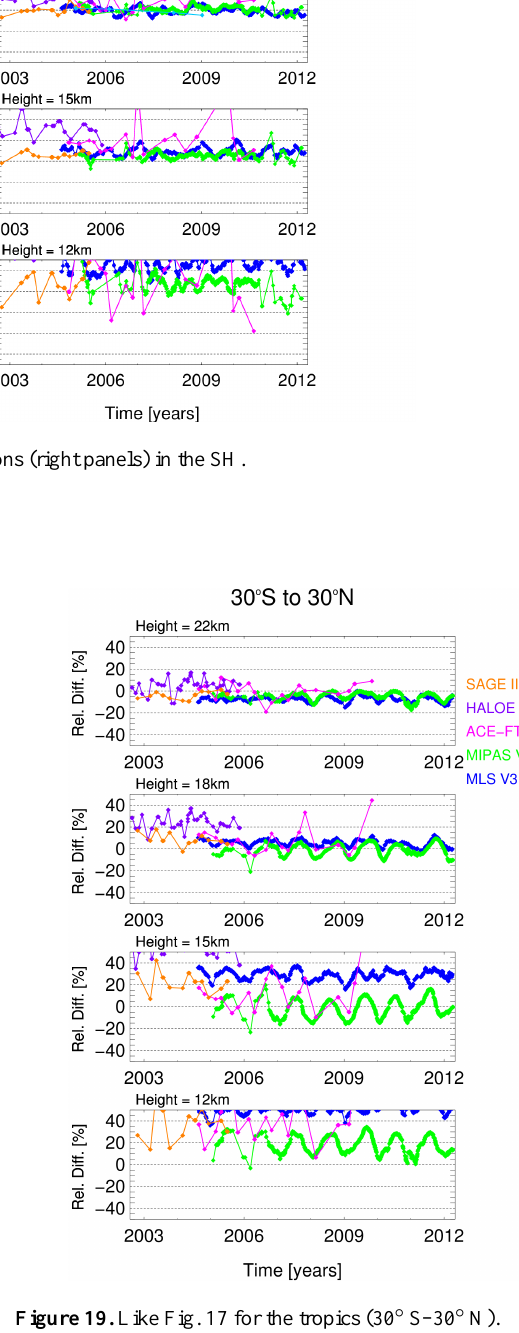
Figure 19. Like Fig. 17 for the tropics (30 ◦ S–30 ◦